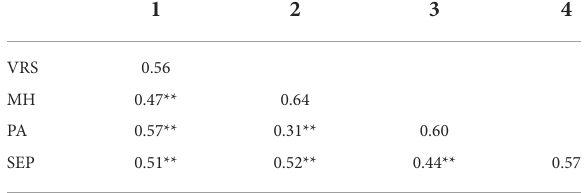
TABLE 6 Construct reliability and validity.